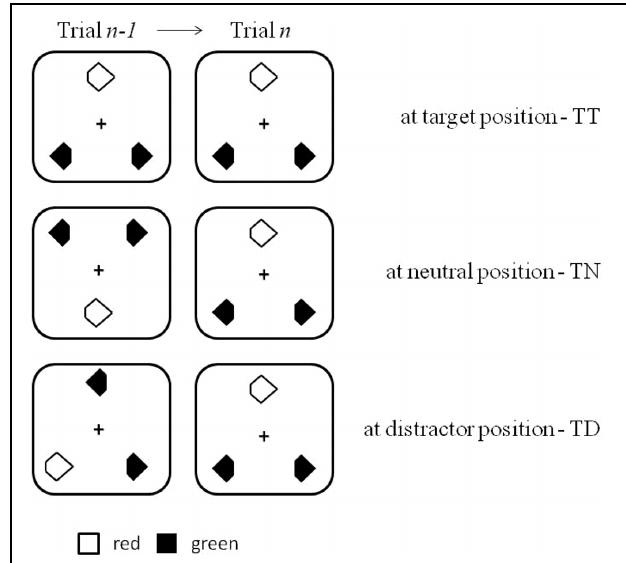
FIGURE 1 | Illustration of the search displays used in the current experiments. Also shown is the location of the target across two successive trials: target at target location (TT), target at neutral, i.e., previously empty, location (TN), and target at distractor location (TD).